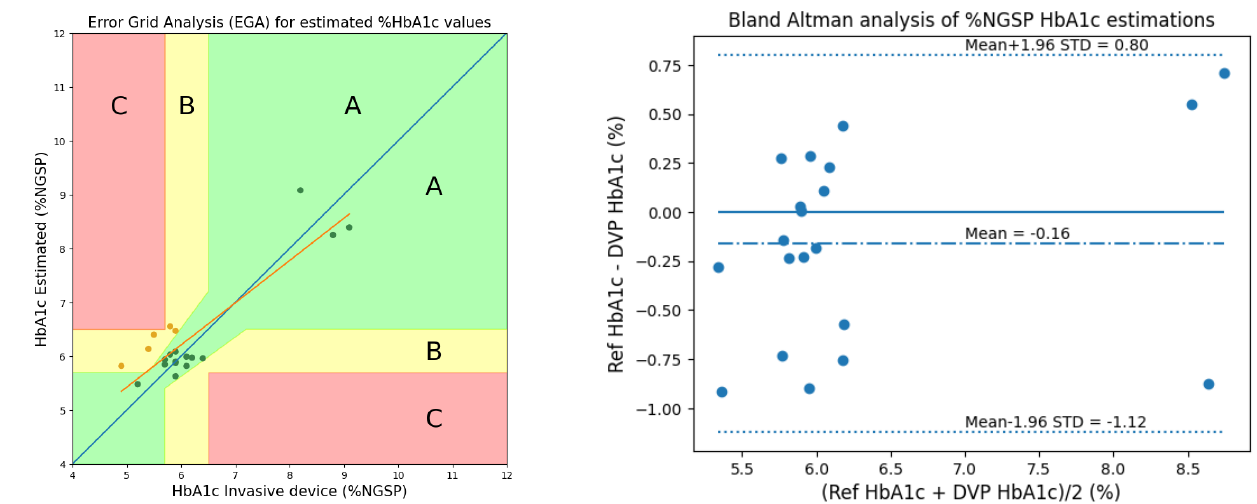
Figure 4. EGA and Bland–Altman analysis for the HbA1c estimation with the blood vessel model (considering ratio calibrations only).